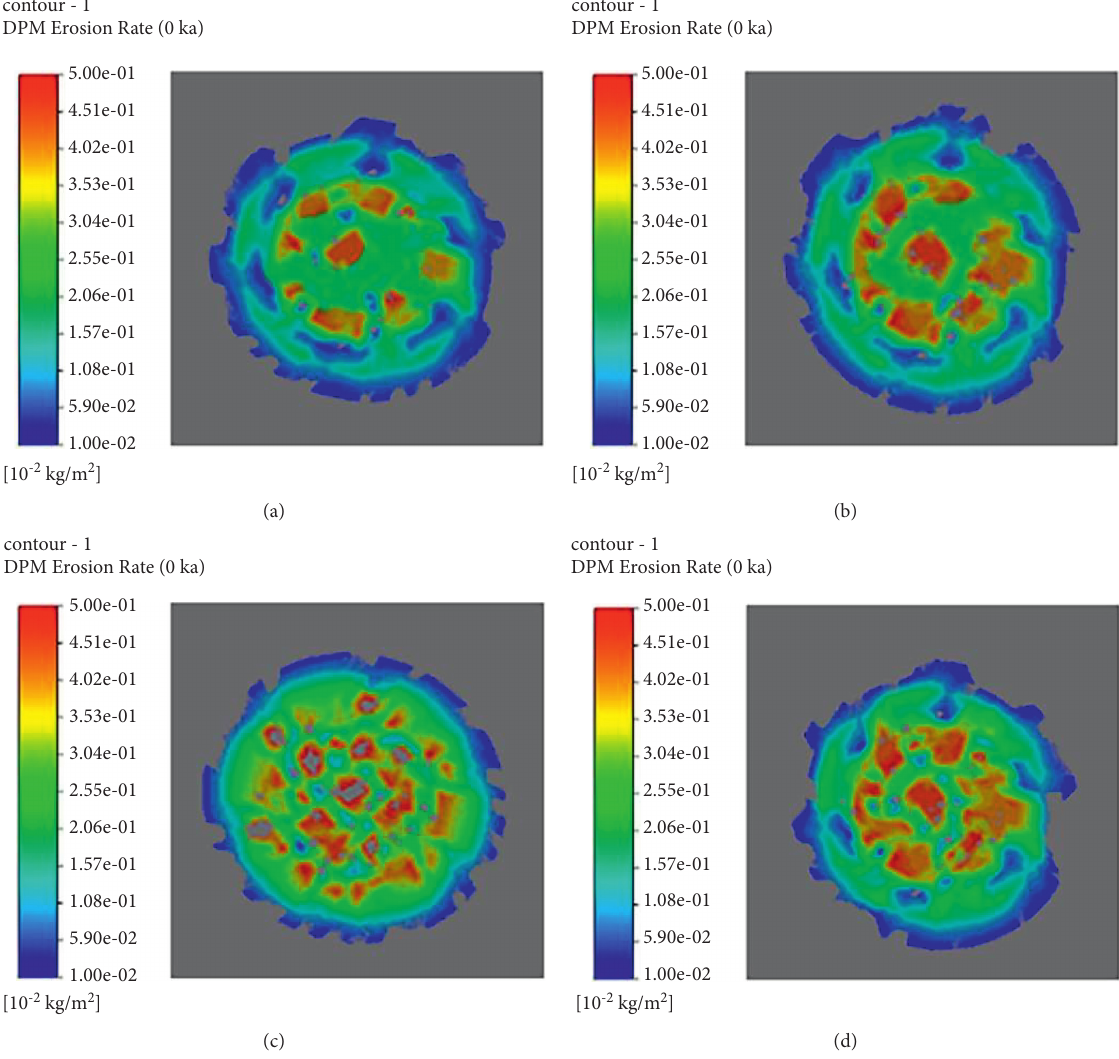
Figure 6: The erosion results of the blade surface with different blasting pressures. (a) The erosion of the blade surface with the blasting pressure of 0.5MPa. (b) The erosion of the blade surface with the blasting pressure of 0.6MPa. (c) The erosion of the blade surface with the blasting pressure of 0.7MPa. (d) The erosion of the blade surface with the blasting pressure of